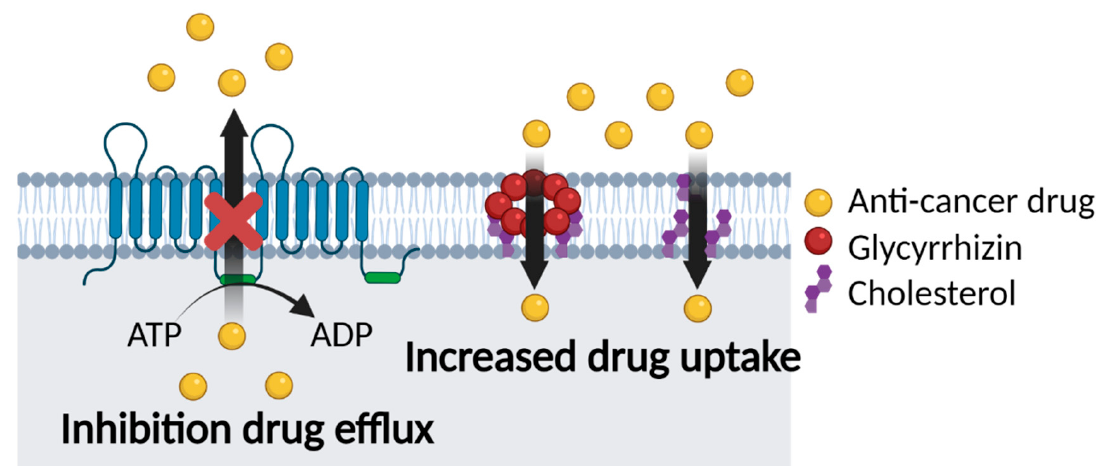
Figure 6. Mechanisms by which GL exerts anti-MDR activity. Image created with BioRender icons. Mechanisms include inhibition of ABC transporters (e.g., P-gp, MRP); GL is incorporated into the lipid bilayer and binds to cholesterol to form pores; GL modifies cell membrane components, thereby increasing elasticity and permeability.